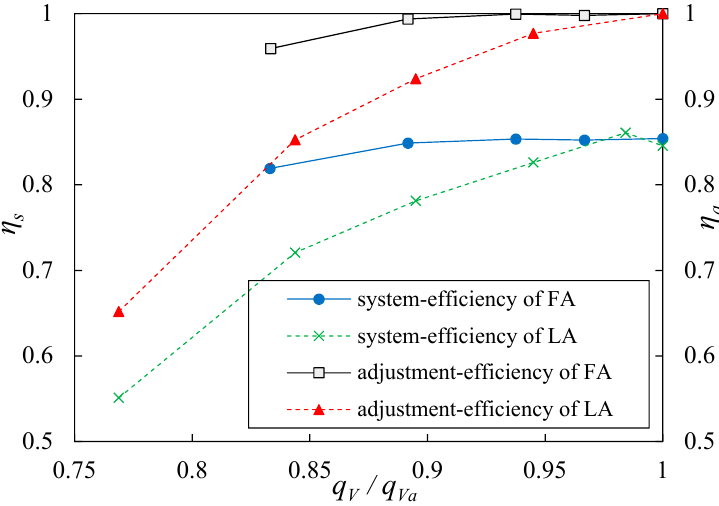
Figure 10. The economic performance curve of different adjustments based on the FE calculation.